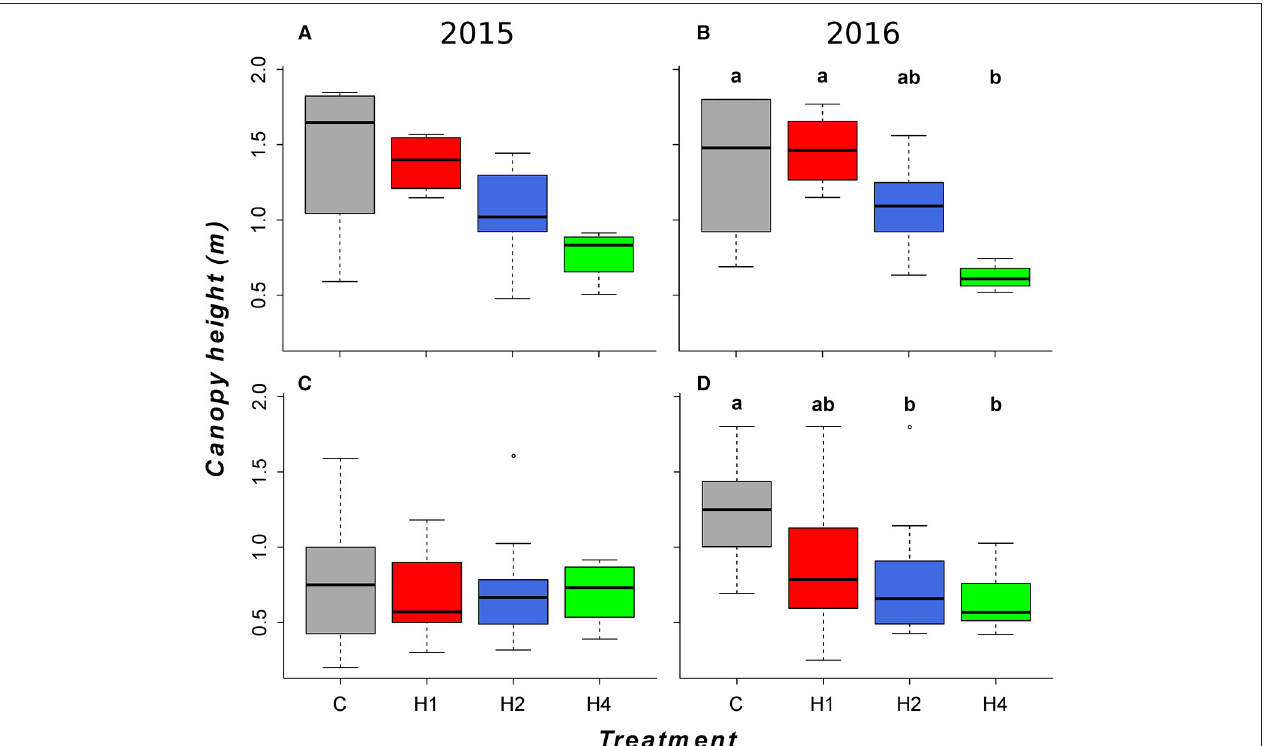
FIGURE 4 | Boxplots of community canopy height for the second and third experimental year for the tall herb fringe (A,B) and the tall grass communities (C,D) . (A,C) 2015, (B,D) 2016. Horizontal lines indicate the median, boxes the interquartile range and whiskers the 95% interval of the data. Treatment designation as in Figure 1 . Different letters indicate significant difference ( p < 0.05) tested by linear mixed effects model with post-hoc test for pairwise comparisons (for details, see Appendix Table 4 in Supplementary Material. Community-weighted medians (min, max) after the first experimental year (non-significant, LMEM, see Appendix Table 5 in Supplementary Material) as well as boxplots for the other tested community types (non-significant, LMEM) can be found in Appendix Image 4 (Supplementary Material).